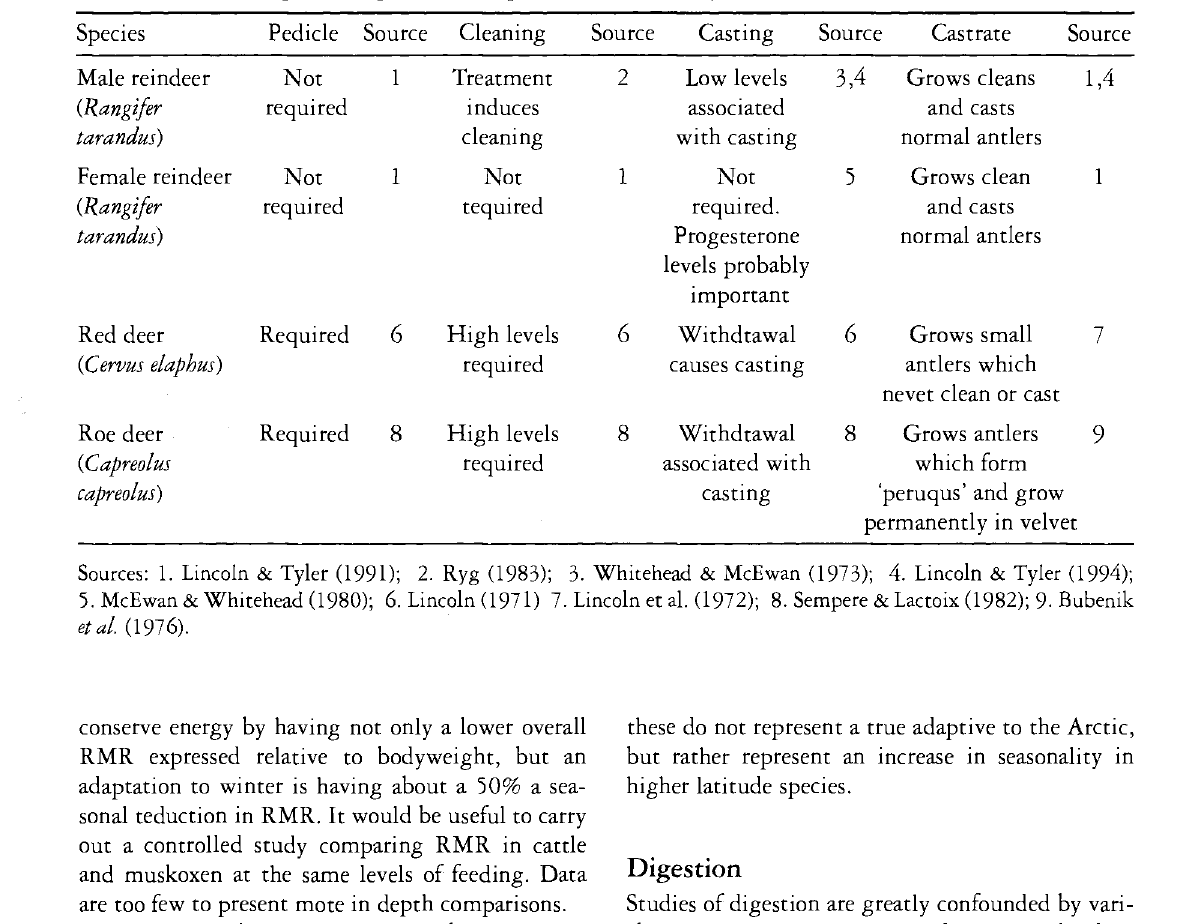
Table 5. Role of androgens during antler development and the antler cycle. Species